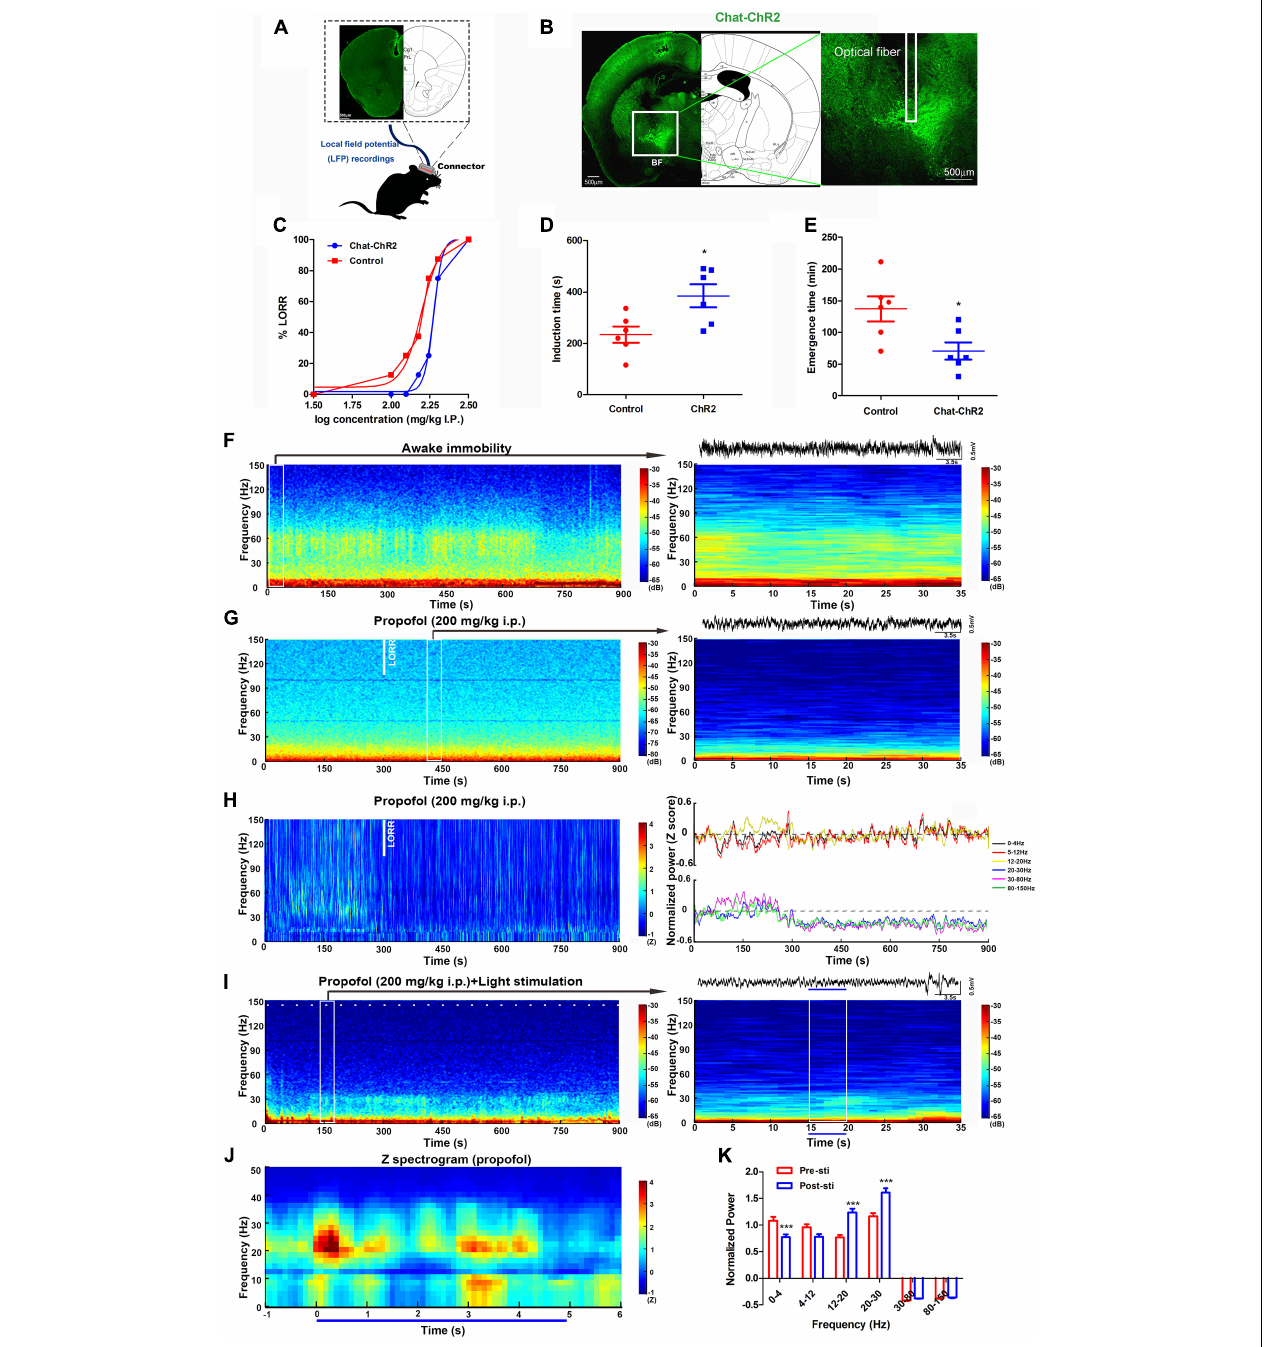
FIGURE 2 | Optogenetic activation of cholinergic neurons in the BF reversed propofol anesthesia with mPFC LFP change. (A) The location of electrodes embedded in the mPFC. (B) Typical placement of optical fibers over the injection site and ChR2-expressing cholinergic neurons. (C) The dose-response curve plotted from the proportion of mice losing the righting reflex under graded propofol ( n = 12 in both groups). Induction (D) and emergence (E) time after stimulation of BF cholinergic neurons when exposed to propofol at the dosage of 200 mg/kg ( n = 6 both). ∗ P < 0 . 05, compared with the control group. (F) Typical mouse spectrogram during the awaking state (left), and an enlarged, 35 s spectrogram with raw LFP data (right). (G) 15-min spectrogram (left) and a 35 s enlarged time window with raw LFP data (right) from a typical mouse during propofol anesthesia. (H) Normalized spectrogram averaged from six mice (left) and power differential at 0–4, 5–12, 12–20, 20–30, 30–80, and 80–150 Hz (right). (I) 15-min spectrogram (left) and an enlarged 35-s time window with raw LFP data from a typical mouse during propofol anesthesia with light stimulation (right). White dashes (left) and blue line (right) represent light stimulation. (J) Normalized spectrogram computed from nine mice under light stimulation during propofol at 200 mg/kg, trial = 52). (K) Post hoc analysis of the power at 0–4, 5–12, 12–20, 20–30, 30–80, and 80–150 Hz for 5 s before and after light stimulation during propofol at 200 mg/kg. “0” means the onset of propofol administration in the Figures (G,H,I) . ∗∗∗ P < 0 . 001, compared with the pre-sti group at every frequency